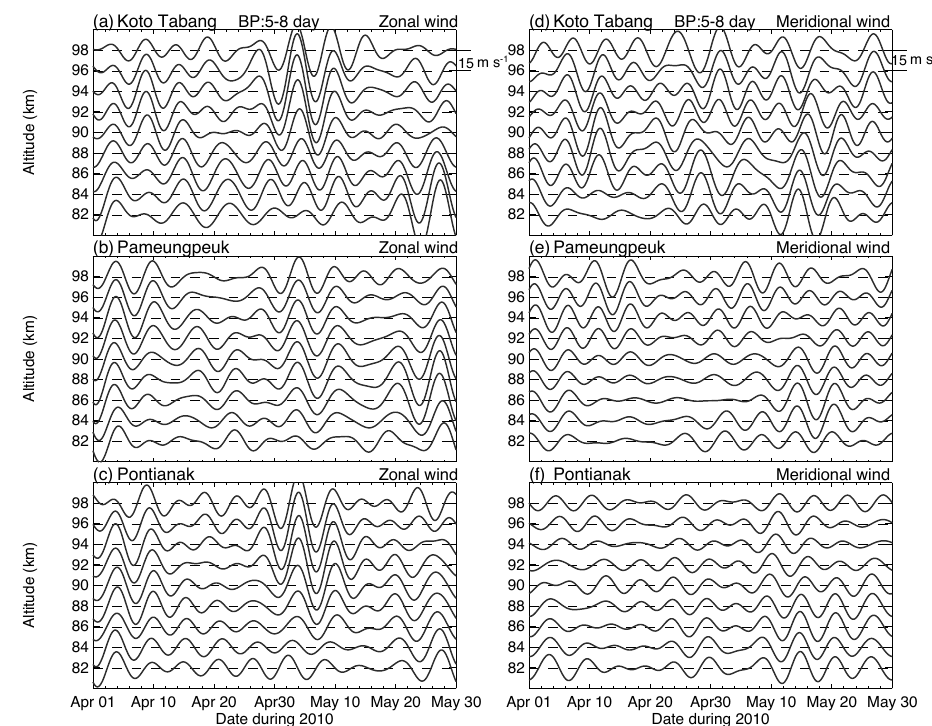
Figure 8. The band-pass filter results of the zonal (a, b, c) and meridional (d, e, f) winds at Kototabang, Pameungpeuk, and Pontianak. The bandwidth is 5–8 days and the interval is 15ms − 1